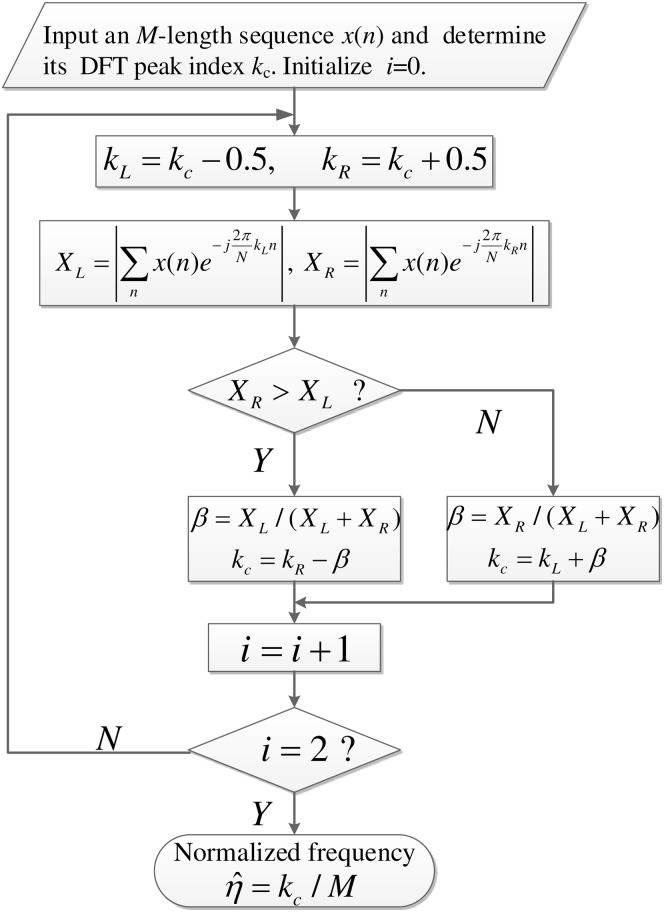
Dataflow of the Tsui spectrum corrector.